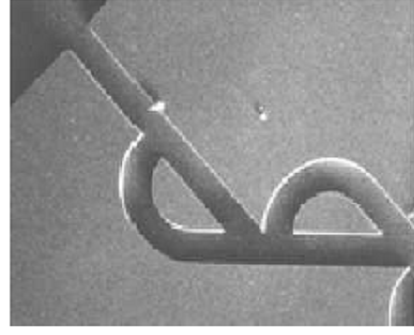
Fig. 1: A rotated scanning electron microscope photograph of a Tesla valve by Forster et al. [8]